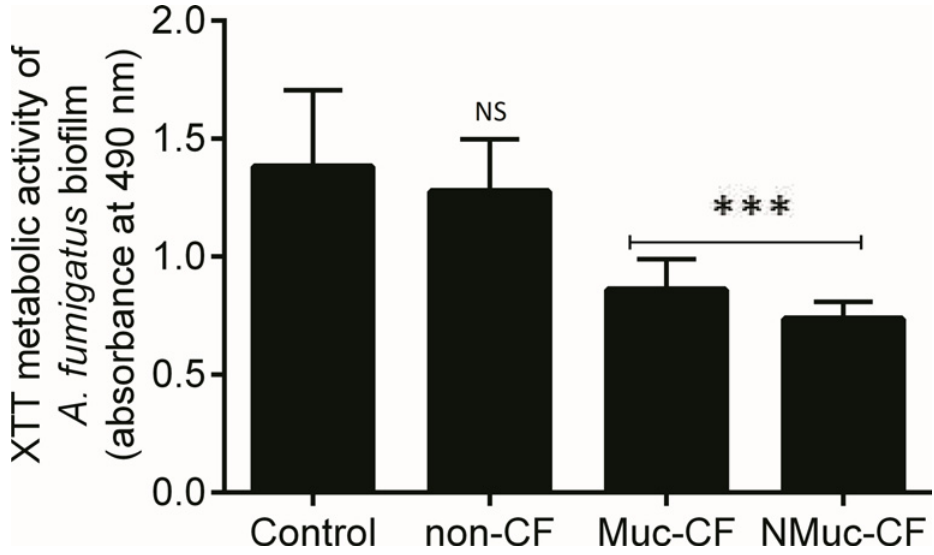
Fig 1. Inhibition of A . fumigatus biofilm formation of P . aeruginosa ( Pa ) biofilm culture filtrates: non- CF Pa isolate, mucoid CF Pa isolate (Muc-CF), and nonmucoid CF Pa isolate (NMuc-CF). Bars represent metabolic activity as measured by the XTT assay and by spectrophotometry at 490 nm. Assays were performed in triplicate and results are presented as the mean of three replicates. Error bars represent the standard deviation of the mean. *** p < 0.0001 (compared with untreated controls).